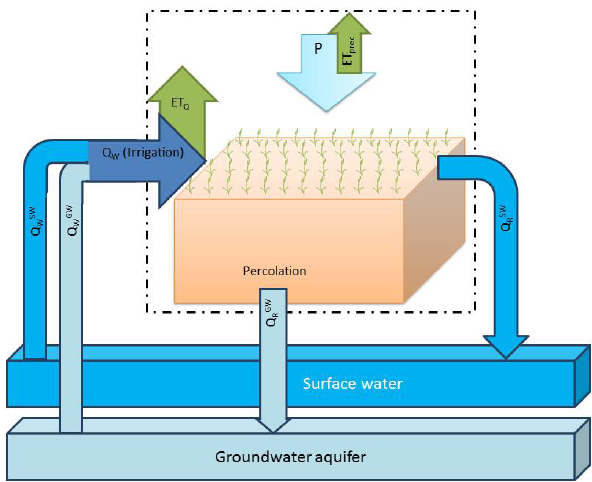
Fig. 1. Basic diagram explaining fundamental differences between gross and net withdrawals in relation to incremental